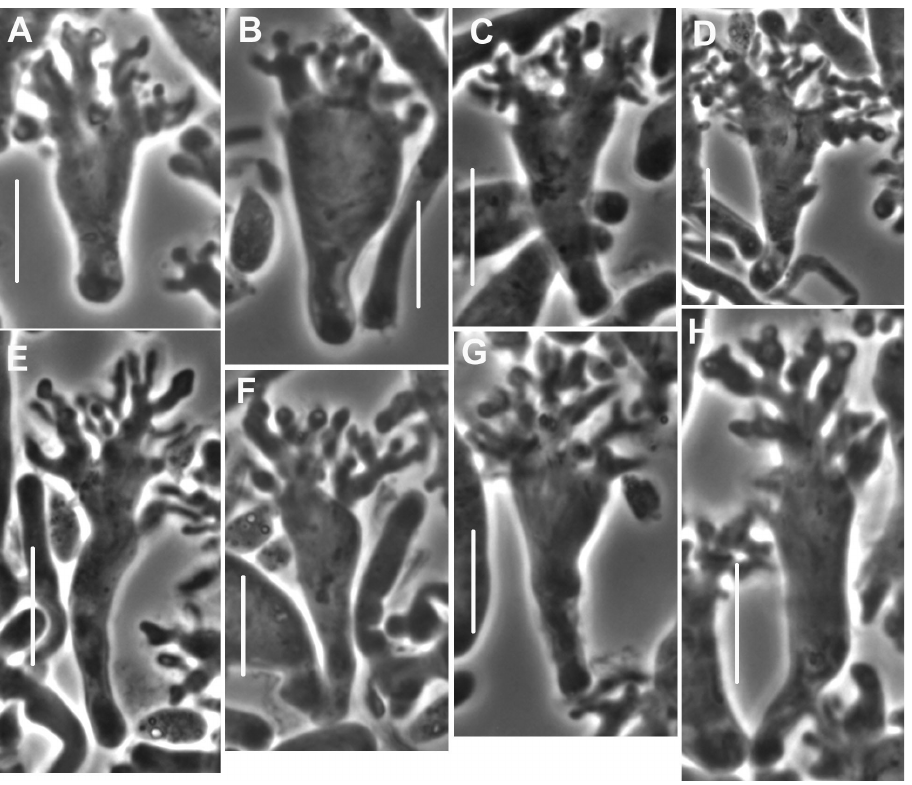
Figure 76. Mycetinis scorodonius . Cheilocystidia. Standard bars = 10 µm. TFB 7261